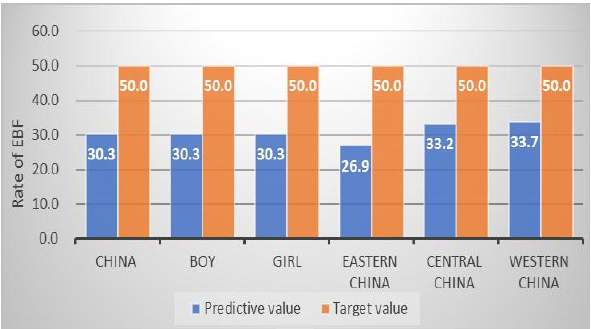
Figure 4. The estimated exclusive breastfeeding (EBF) rate of Chinese children and SDG target in 2025 (%).